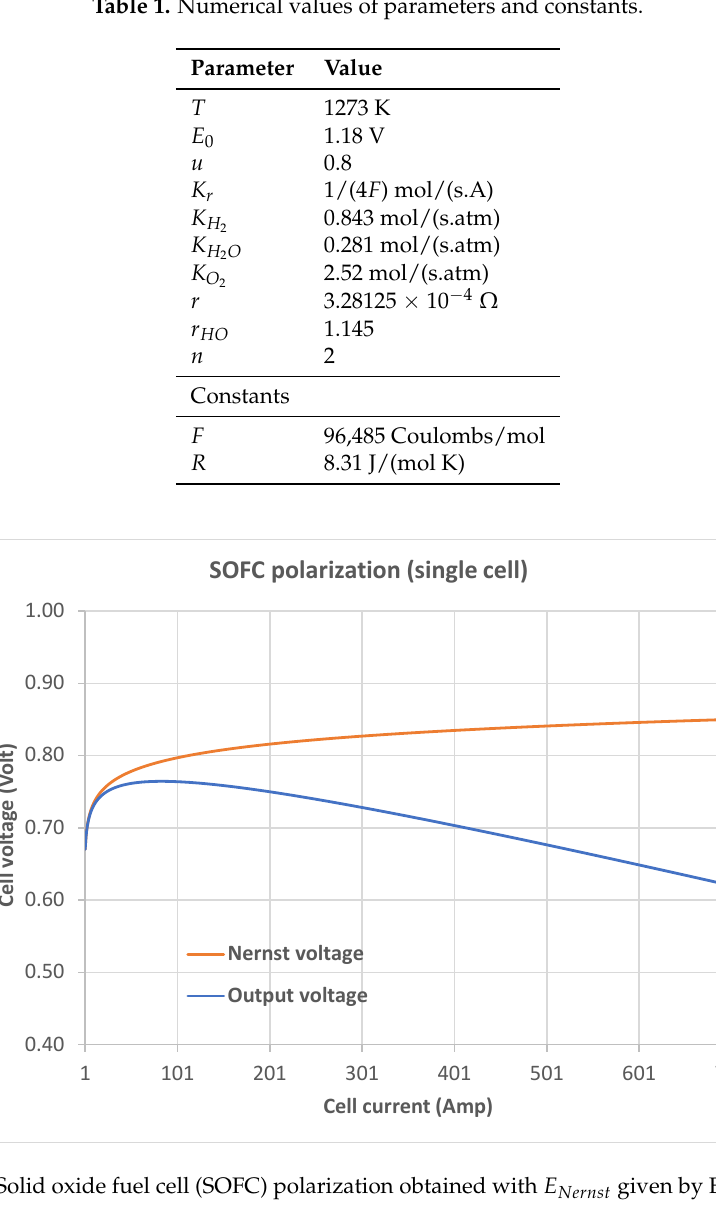
Table 1. Numerical values of parameters and constants.